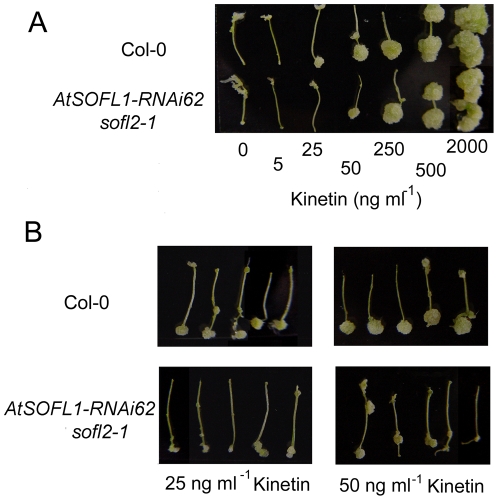
Response of SOFL1-RNAi62 sofl2-1 and wild-type plants to exogenous cytokinins.Response of root explants from SOFL1-RNAi62 sofl2-1 and wild-type seedlings to different cytokinin concentrations. The upper-part hypocotyl segments were cultured for 24 days on medium containing 10 ng ml−1 2,4-dichlorophenoxyacetic acid (2,4-D) and different concentrations of kinetin (A) or at the concentration of 25 ng ml−1 and 50 ng ml−1 kinetin (B).